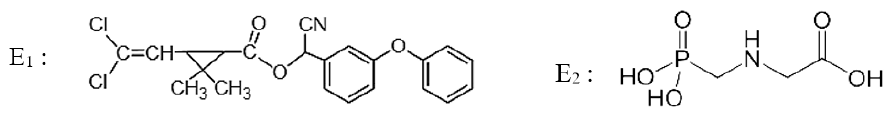
Figure 1 . Molecular structure of cypermethrin (E 1 ) and glyphosate (E 2